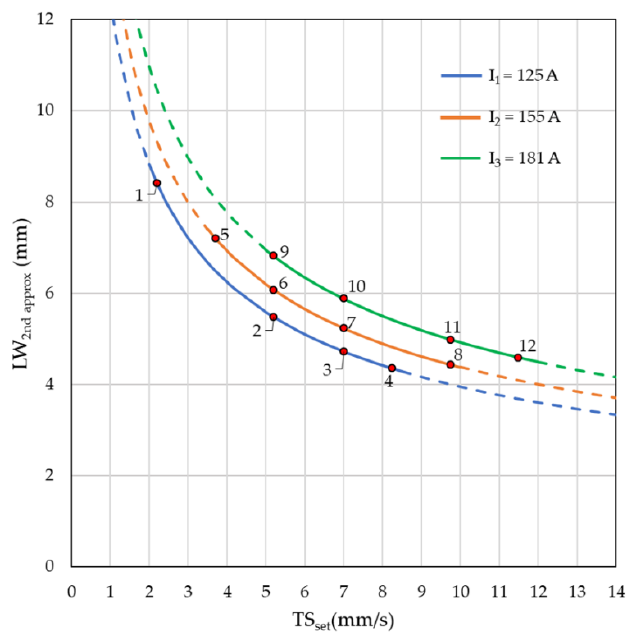
Figure 13. Superimposition of the final experimental design (4 travel speeds for each of the 3 currents = 12 experiments) over the second approximation operational map. Table 6. Experimental matrix for the final design for the experiments.